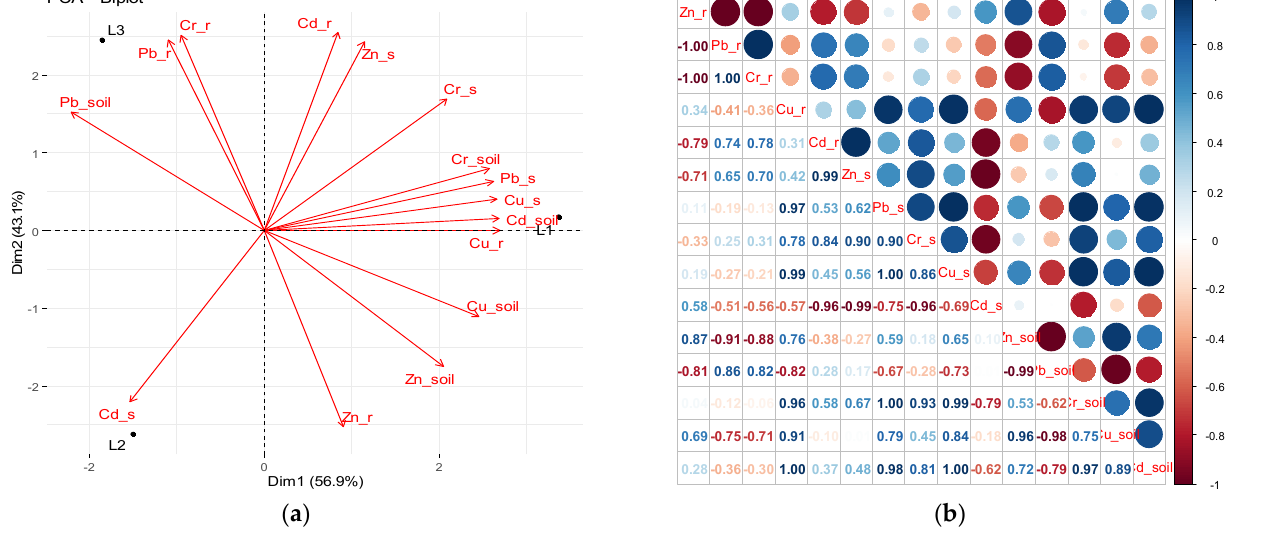
Figure 5. Principal components analysis (PCA) ( a ) and a heatmap of Pearson moment correlation coefficients ( b ) for heavy metal (Zn, Pb, Cr, Cu, and Cd) content in the root (r) and stem (s) of wheat in phenophase of heading in different localities (L1—Locality 1; L2—Locality 2; and L3—Locality 3).